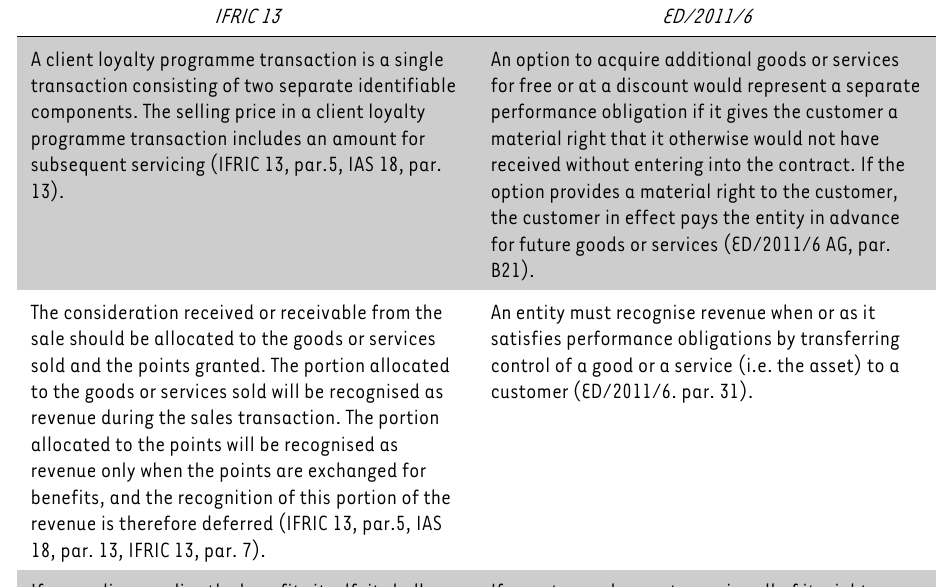
TABLE 1: Comparing the guidelines of IFRIC 13 and ED/2011/6 IFRIC 13